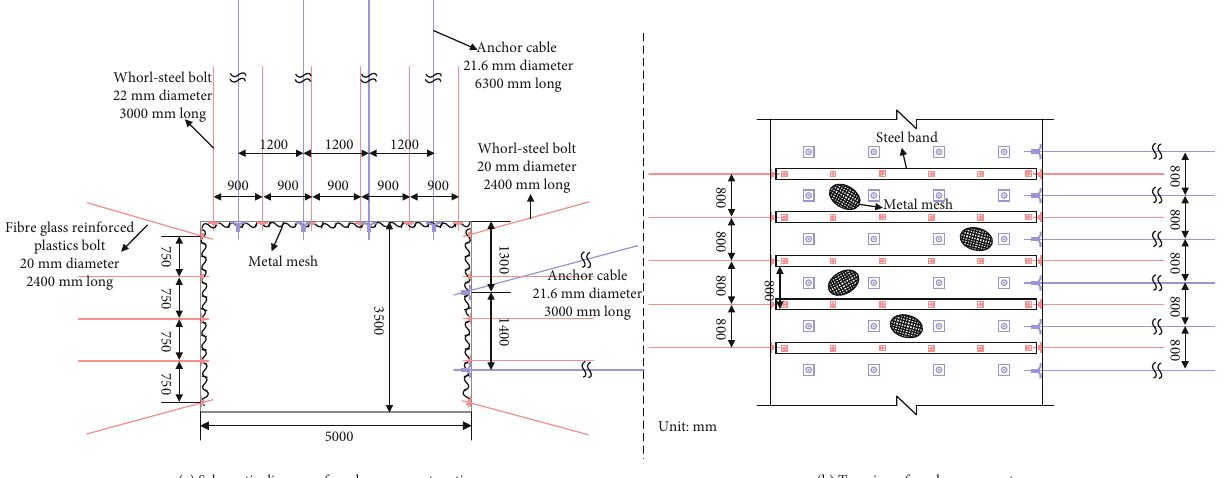
Figure 11: Roadway support design